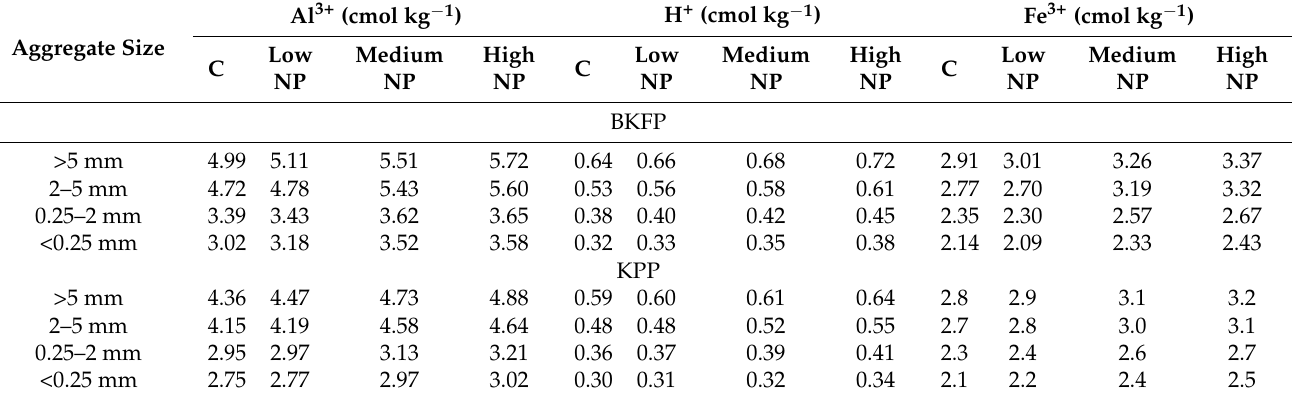
Table 4. Aluminium ion (Al 3+ ) (cmol kg − 1 ) hydrogen ion (H + ) (cmol kg − 1 ) and iron ion (Fe 3+